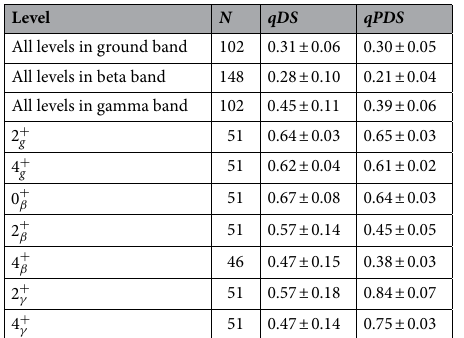
Table 2. Similar to Table 1, q values describe the statistical situation of considered levels determined by DS and PDS formalism.